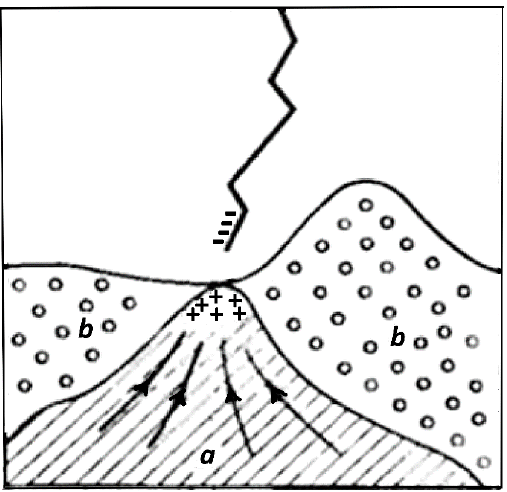
Figure 1. Selective susceptibility to lightning discharges: soil with high electrical conductivity ( a ); soil with low conductivity ( b ).